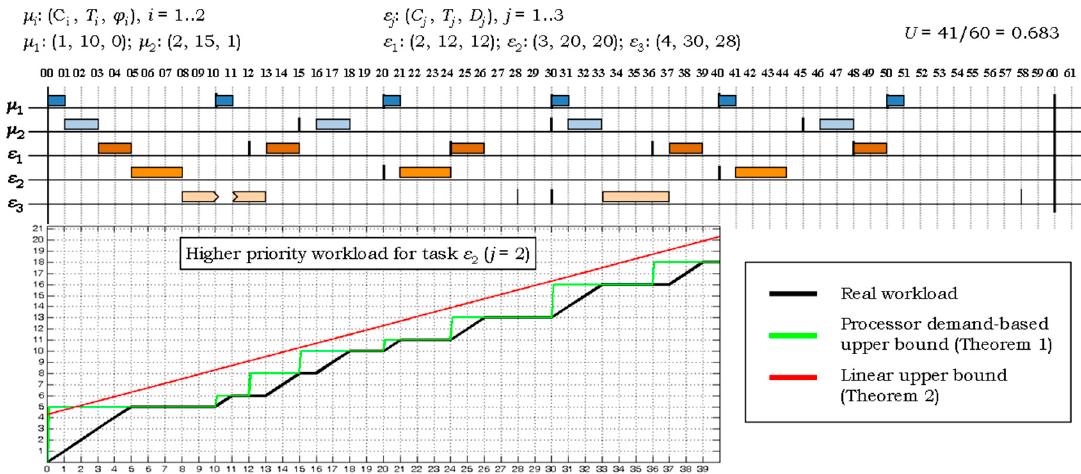
Figure 4. Example system of N = 5 hard real-time tasks: its H 2 RTS schedule and the higher priority workload for the task ε 2 .